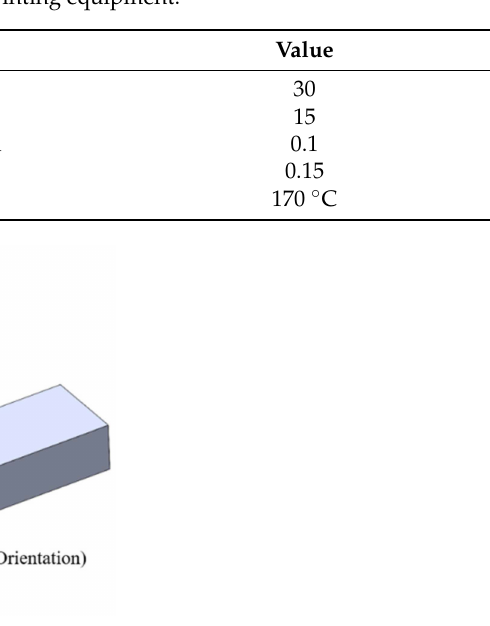
Figure 2. Schematic of type V dog bones in three build orientation axes.